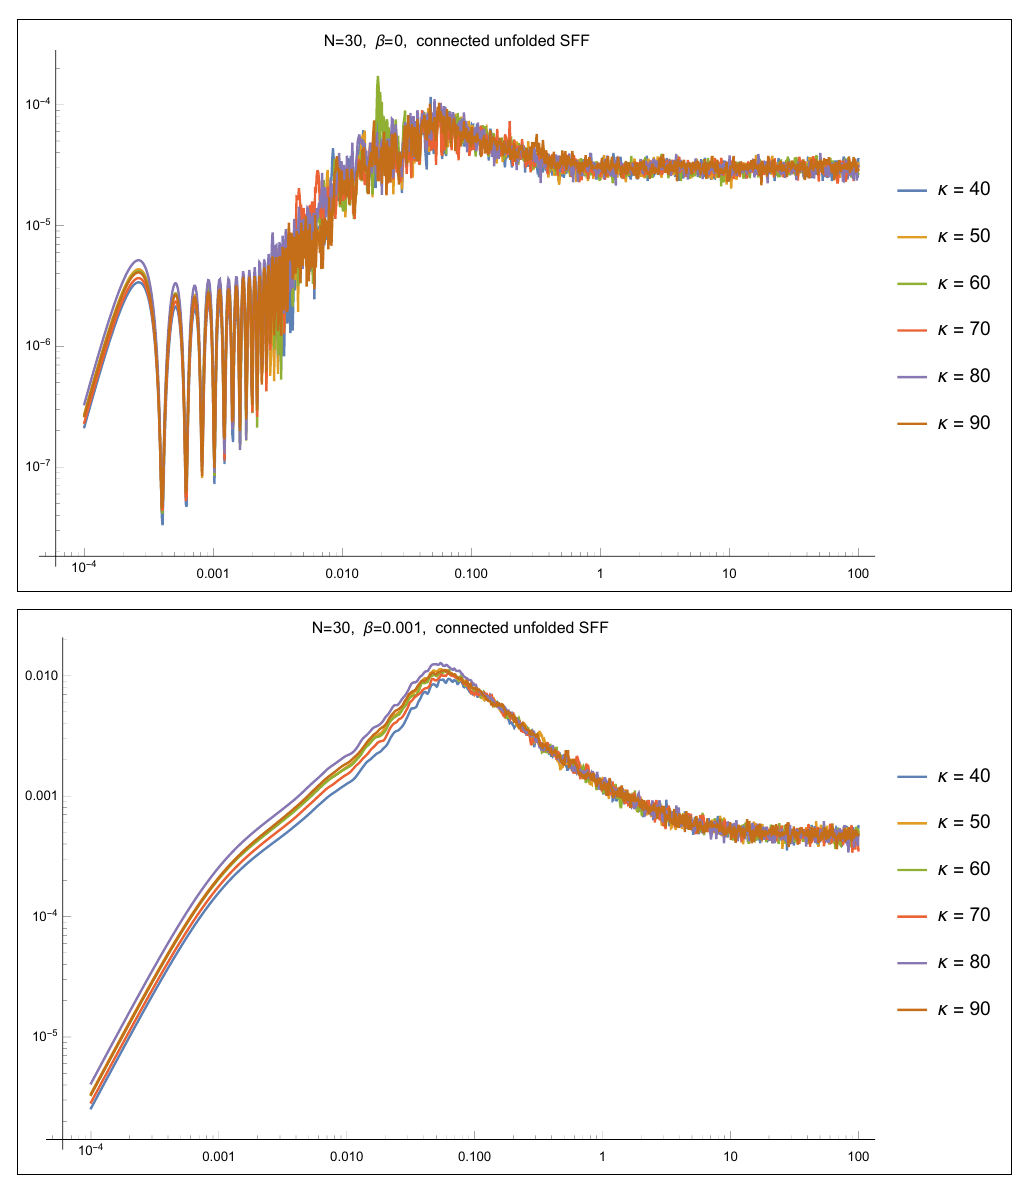
Figure 6 . The connected unfolded SFF for N = 30 and large (cid:20) . The average is performed over M = 101